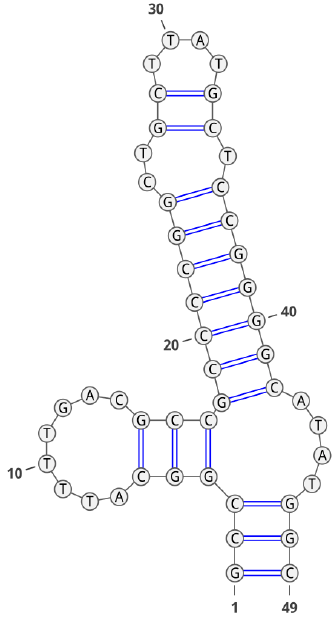
Figure 6. Secondary structure of the GOL1 aptamer.